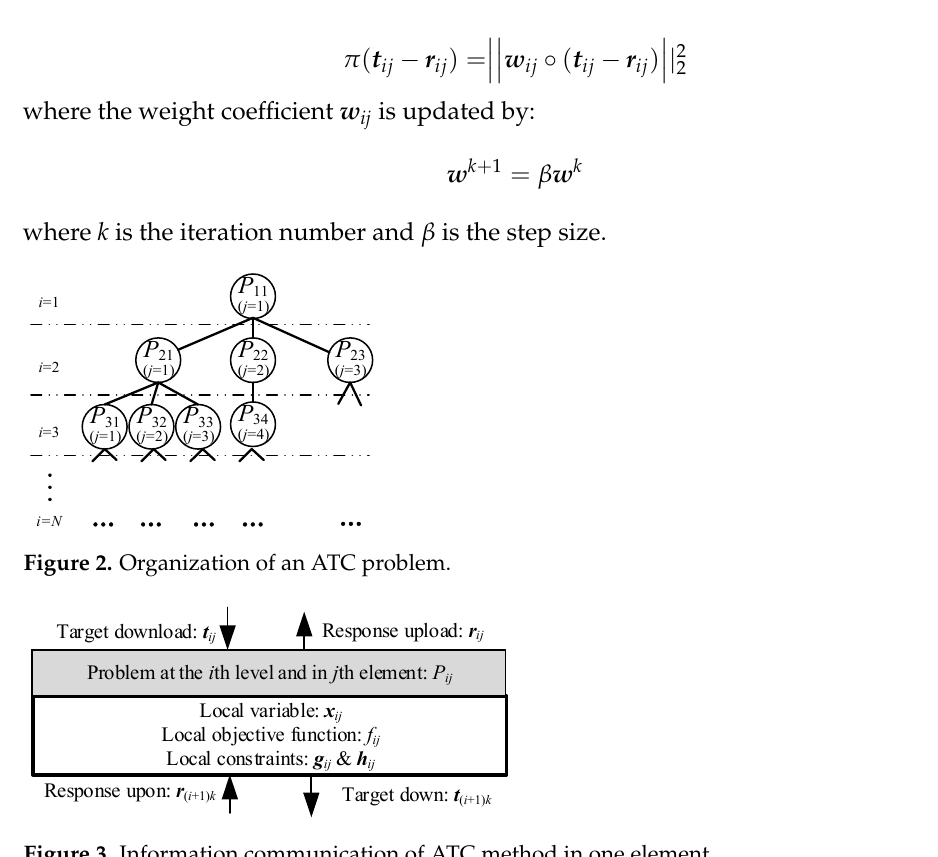
( c ) Figure 1. Frameworks of traditional multi-level MDO methods: ( a ) CSSO; ( b ) CO; ( c ) BLISS. 2. The ATC Method with MIGA 2.1. ATC Method As mentioned above, ATC is a promising approach to solving complex hierarchical